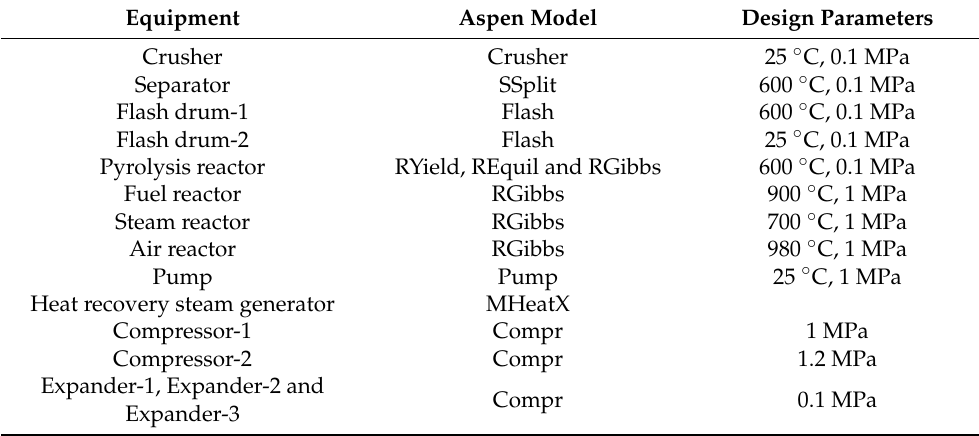
Table 7. Aspen model and input data for the equipment of the proposed system. Equipment Aspen Model Design Parameters